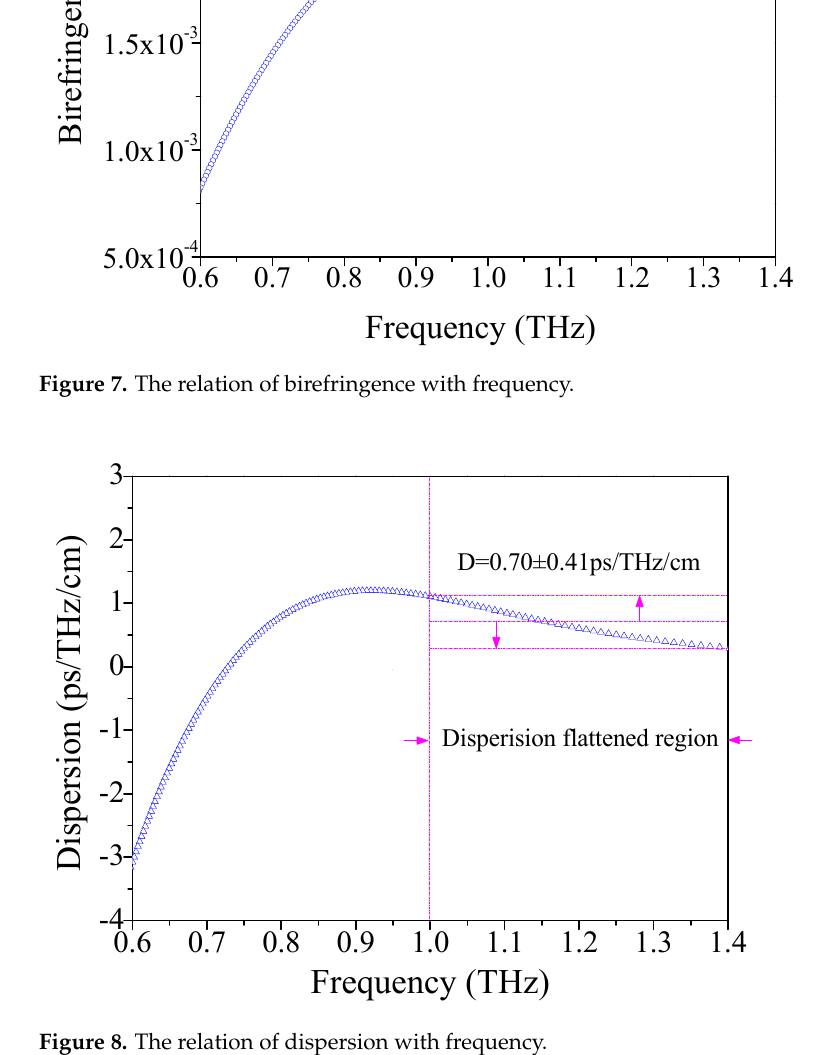
Figure 7. The relation of birefringence with frequency.